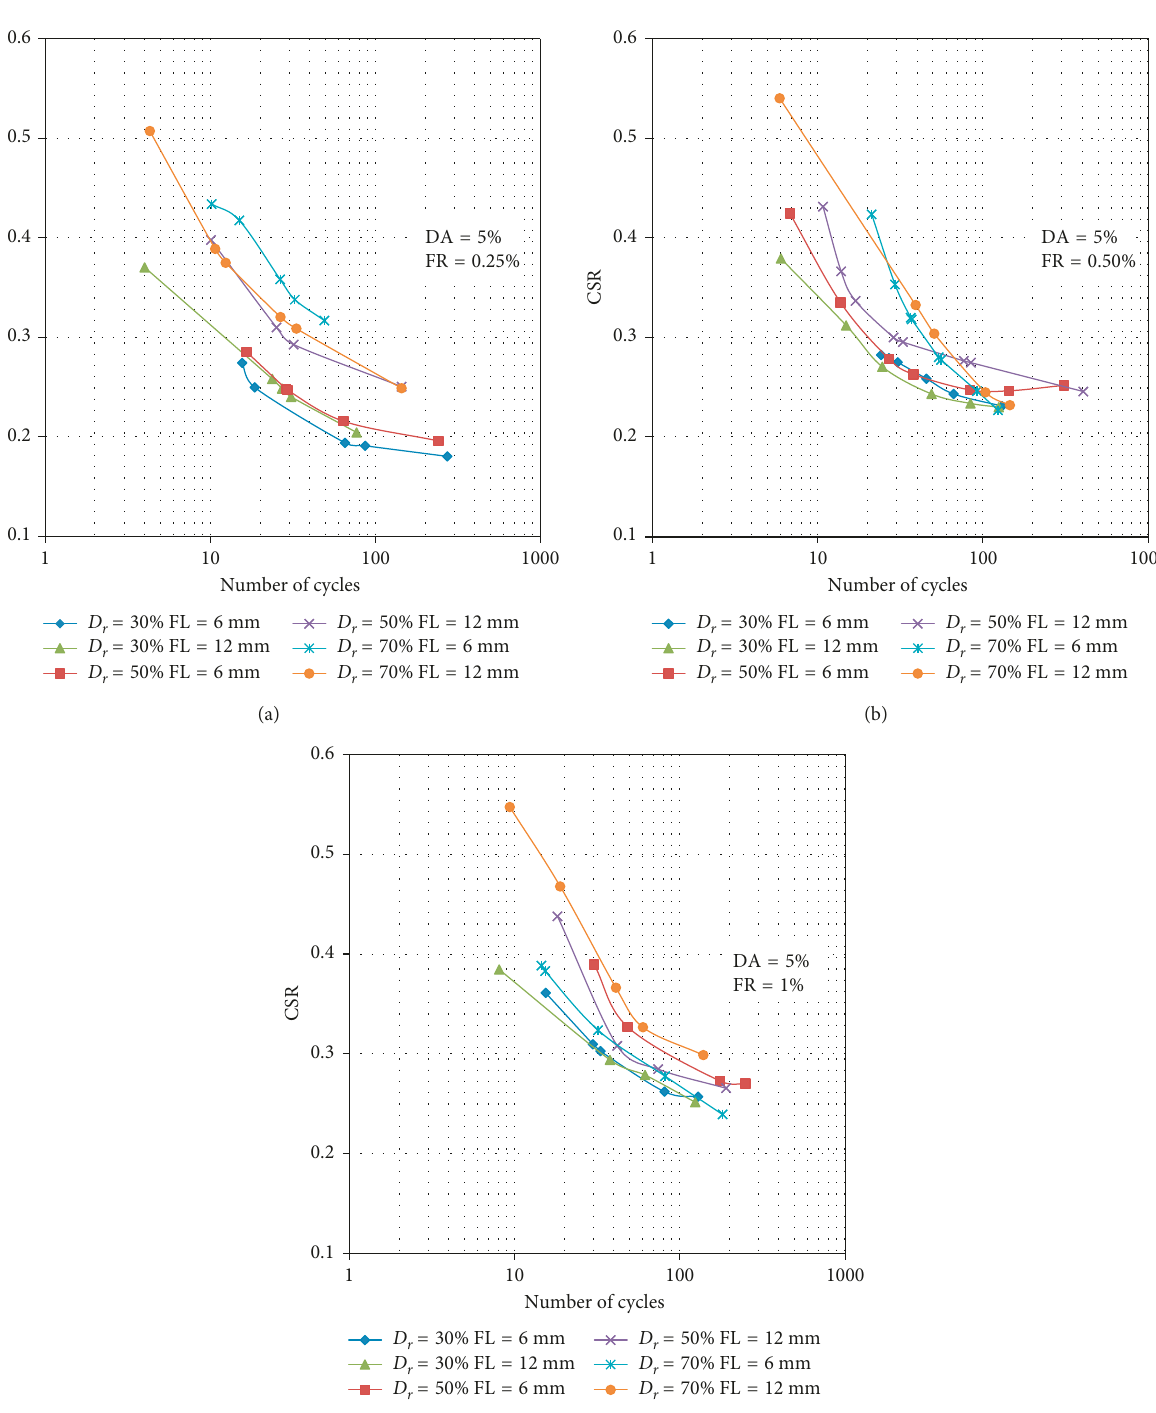
0.25%, (b) FR 0.50%, and (c) FR (cid:31) (cid:31)